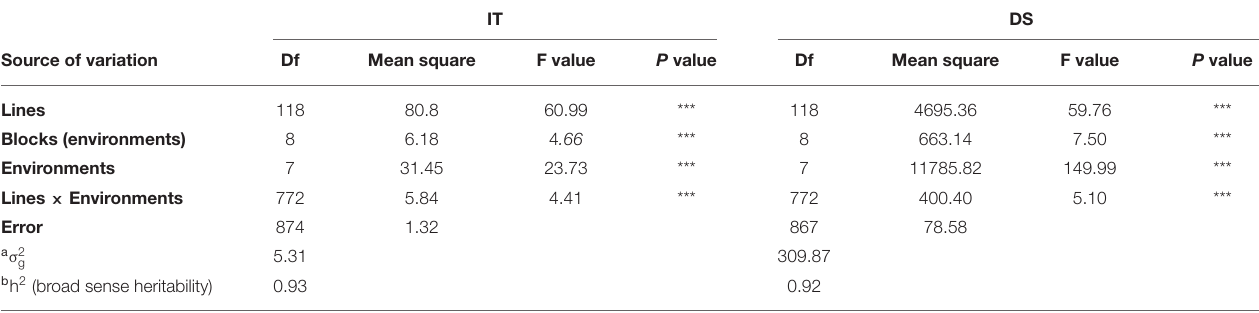
TABLE 2 | Analysis of variance and estimate of broad-sense heritability of the infection type (IT) and disease severity (DS) among 119 RILs from the cross of Mingxian 169 × Pindong 34 tested at Mianyang and Yangling in 2016–2020. IT DS Source of variation